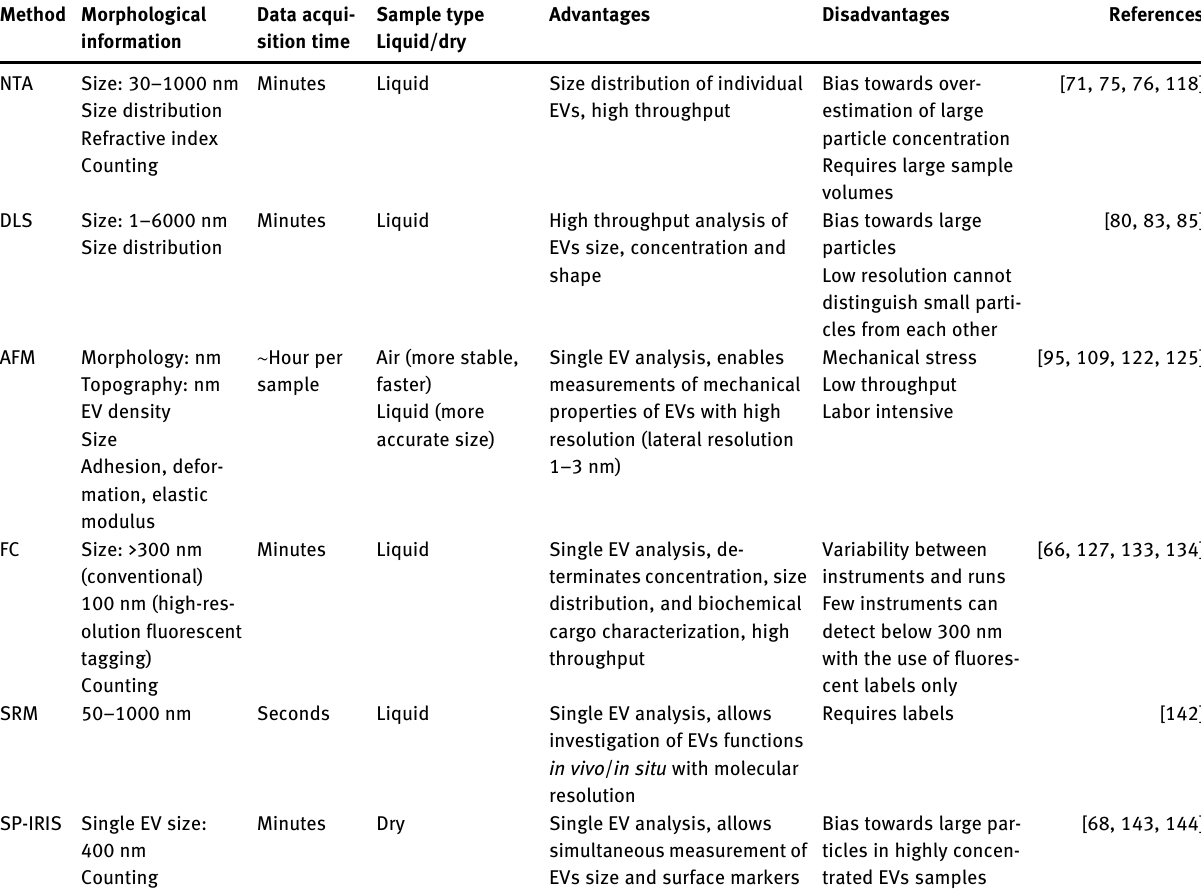
Table  : Summary of label-free optical particle counting, sizing, and morphology characterization methods. Method